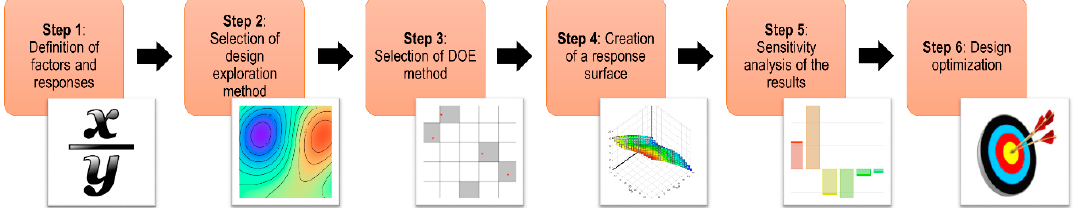
Figure 4. The experimental design process in ANSYS software.